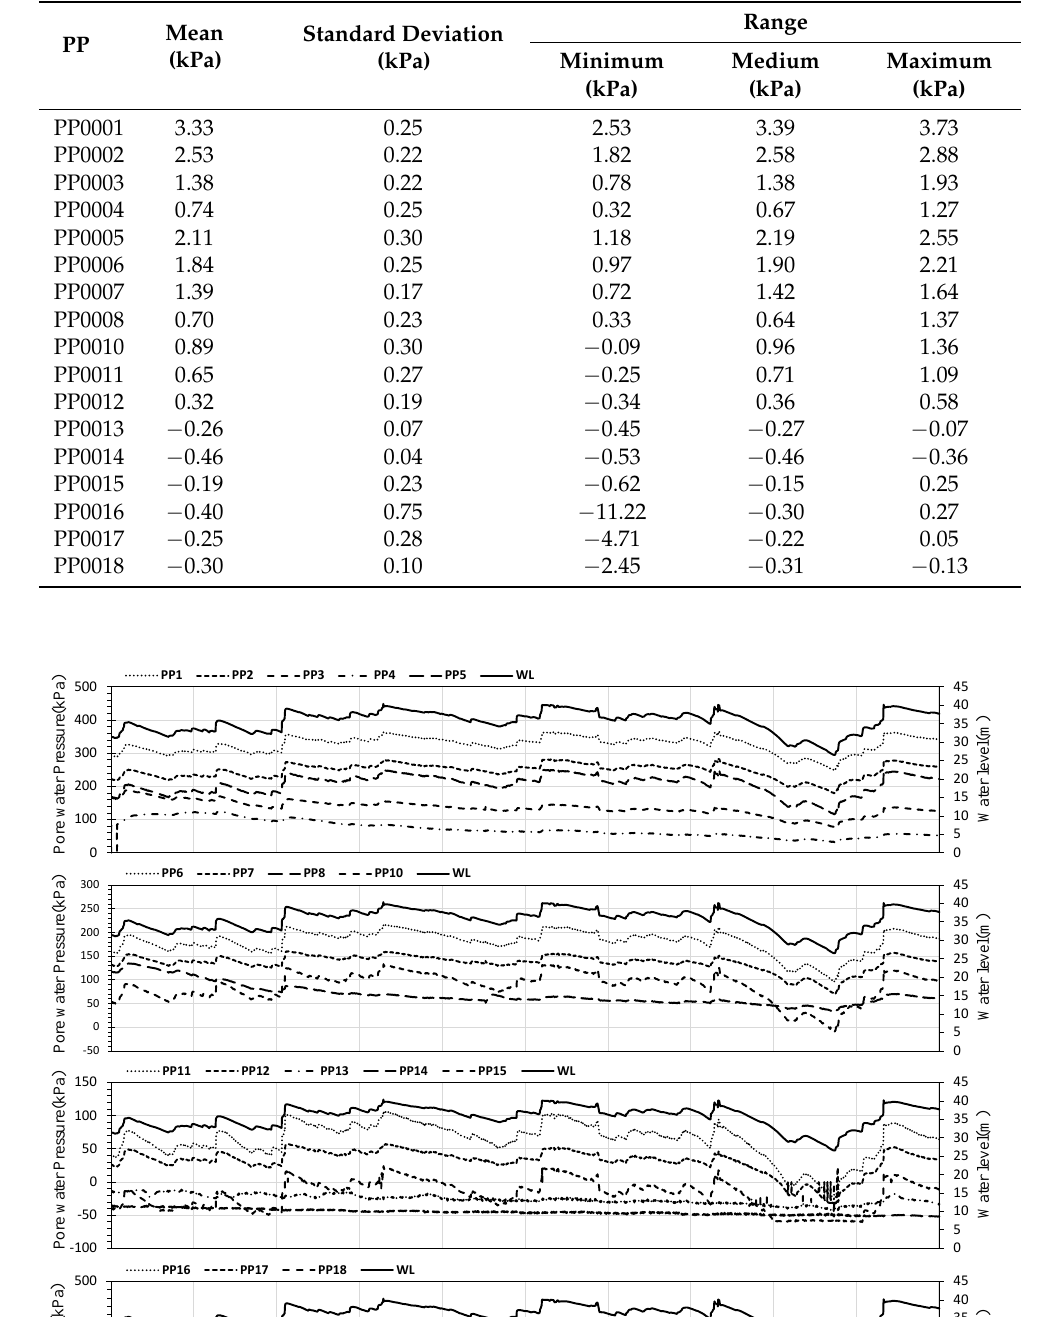
Table 1. Pore pressure gauge technical statistics analysis result.